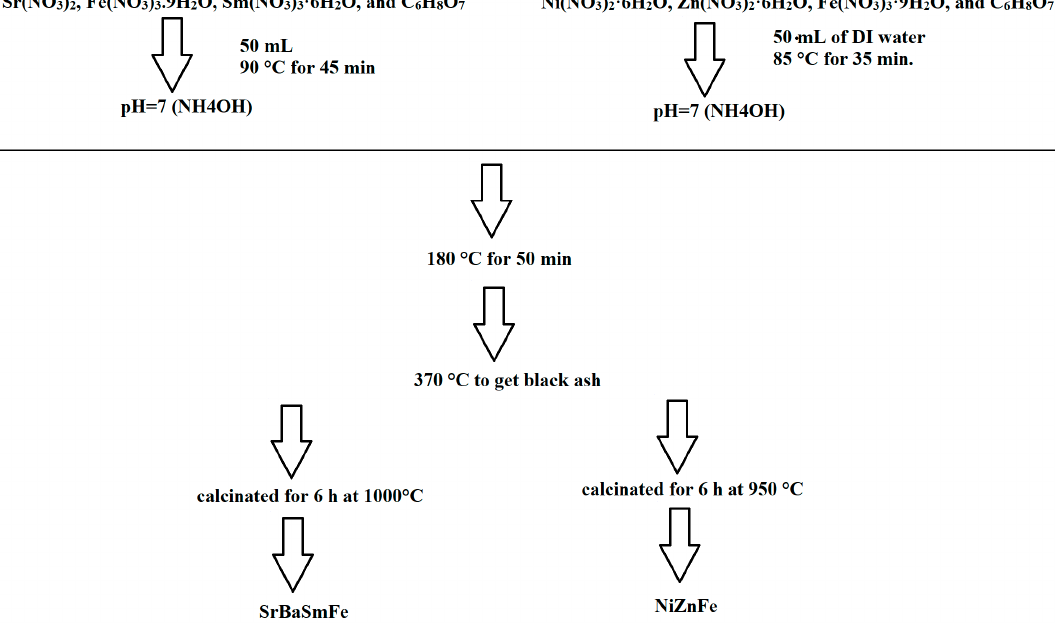
Figure 1. Synthesis stages of SrBaSmFe/ x (NiZnFe) (0.0 ≤ x ≤ 3.0) nanocomposites (NCs).